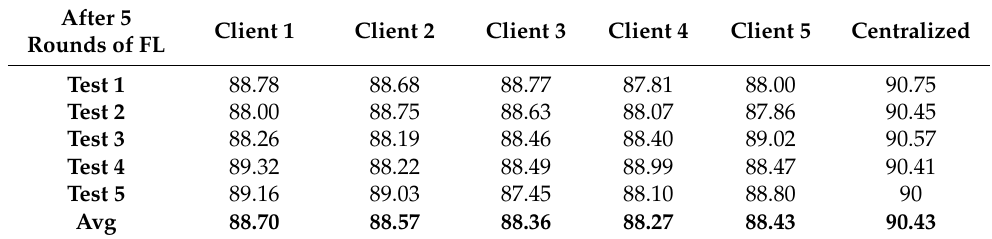
Table 2. Comparison of precision between different clients and centralized model.